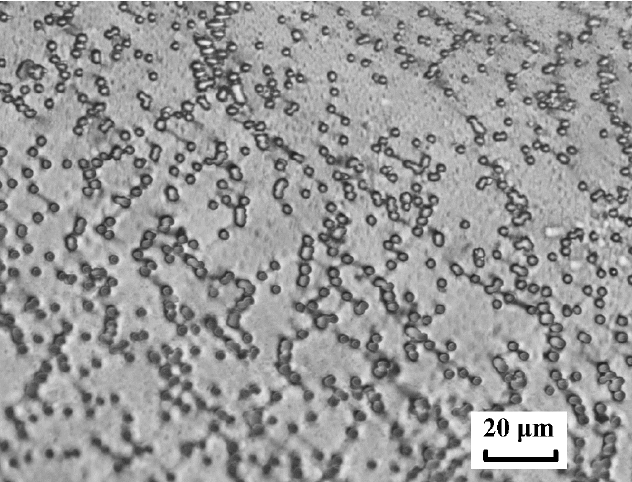
Figure 11. TM with d = 4 μ m and n = 10 6 cm − 2 in polarized light, with deformation of 10%, followed by relaxation. Microcracks are visible along the pore chains. Photo was captured with a Nikon LV100 microscope.